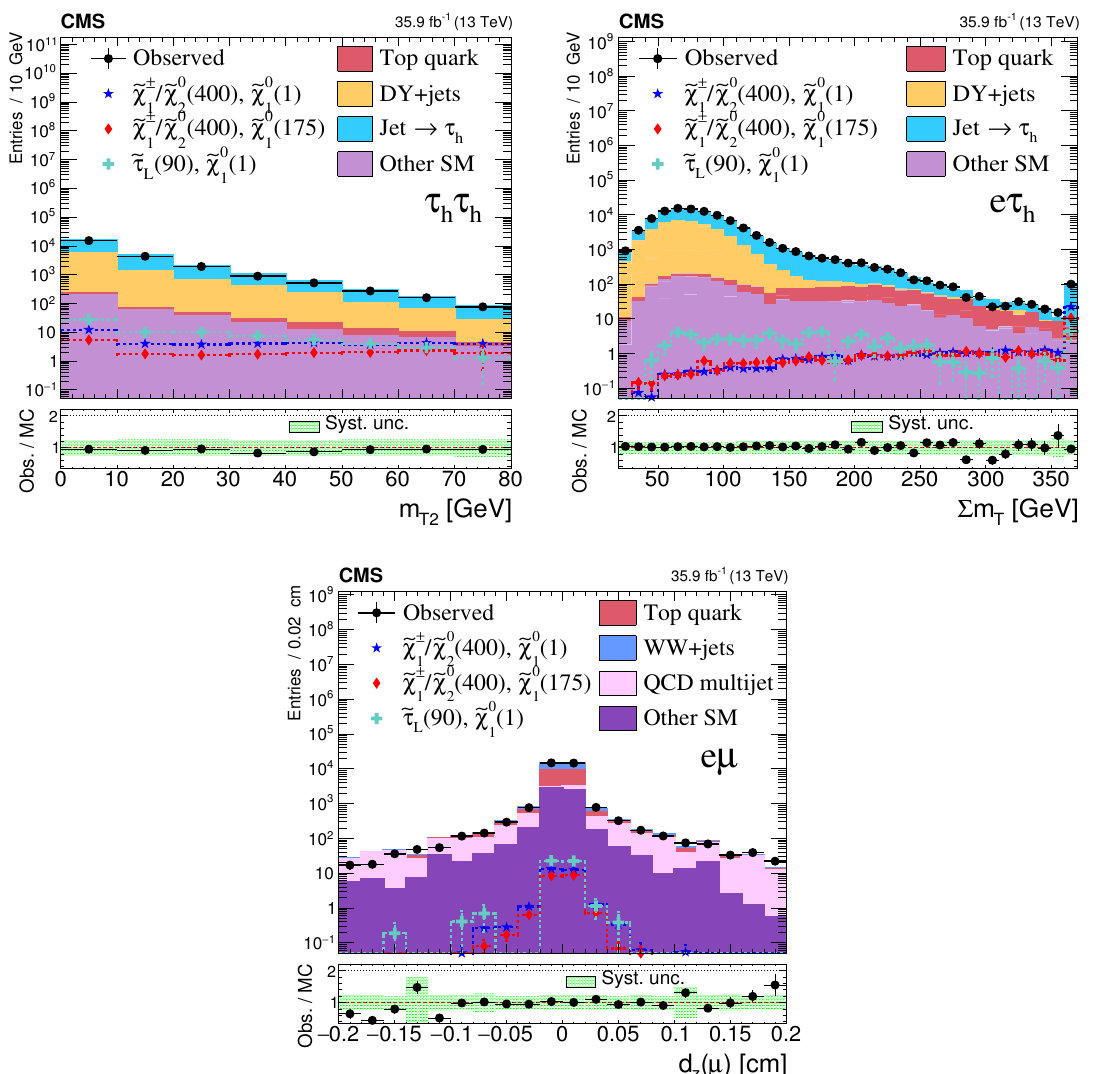
Figure 3. Top left: closure test for the method used to estimate the (cid:28) h misidenti(cid:12)cation rate for the (cid:28) h (cid:28) h (cid:12)nal state in a data control sample where the m T2 or (cid:6) m T requirements used in the SRs are inverted. Top right: (cid:6) m T distribution for events in the e (cid:28) h (cid:12)nal state after the baseline selection, showing the estimation of the background with a jet misidenti(cid:12)ed as a (cid:28) h , which is determined in a signal depleted control region. The last bin includes over(cid:13)ows. Bottom: distribution of the muon d z in the e (cid:22) (cid:12)nal state after the baseline selection, showing the estimation of the QCD multijet background using the matrix method. In the legend,\Top quark" refers to the background originating from tt and single top quark production. In all cases, the predicted and observed yields show good agreement. Distributions for two benchmark models of chargino-neutralino production, and one of direct left-handed (cid:28) pair production, are overlaid. The ratio of signal to background is expected to be small for these selections. The numbers within parentheses in the legend correspond to the masses of the parent SUSY particle and the (cid:31) 0 in GeV for these benchmark models. e 1 e